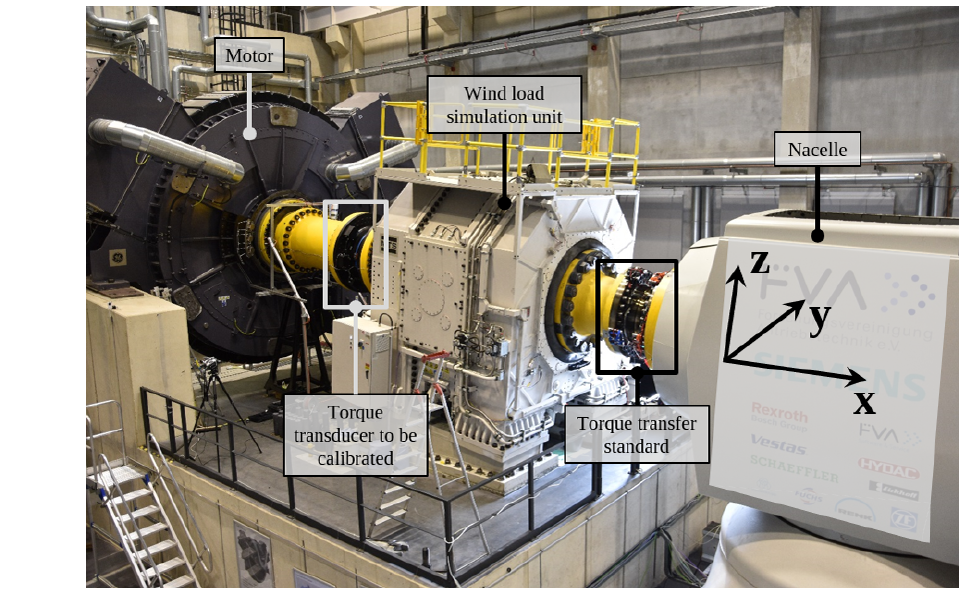
Figure 1. 5MNm TTS, including its data acquisition system (DAQ) and telemetry system, mounted at the rotor hub flange of the wind turbine under test on the WTTB of the Center for Wind Power Drives at RWTH Aachen (edited from Weidinger et al., 2018a).